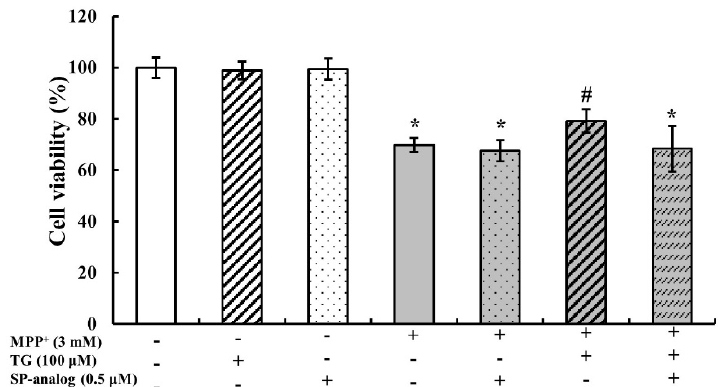
Figure 4. Substance P (SP-analog) attenuated the protective effects of teaghrelin (TG) on 1-methyl-4- phenylpyridinium (MPP + )-induced cytotoxicity. SH-SY5Y cells were treated with TG or SP-analog in the presence or absence of MPP + for 24 h. Cell viability was measured using2,3-bis (2-methoxy-4-nitro- 5-sulfophenyl)-2H-tetrazolium-5-carboxanilide (XTT) assay. The results were analyzed using one- way analysis of variance. Values are presented as the mean ± standard deviation ( n = 4). * p < 0.05 compared with the control group, # p < 0.05 compared with MPP + alone. -: untreated with drugs or compounds, +: treated with drugs or